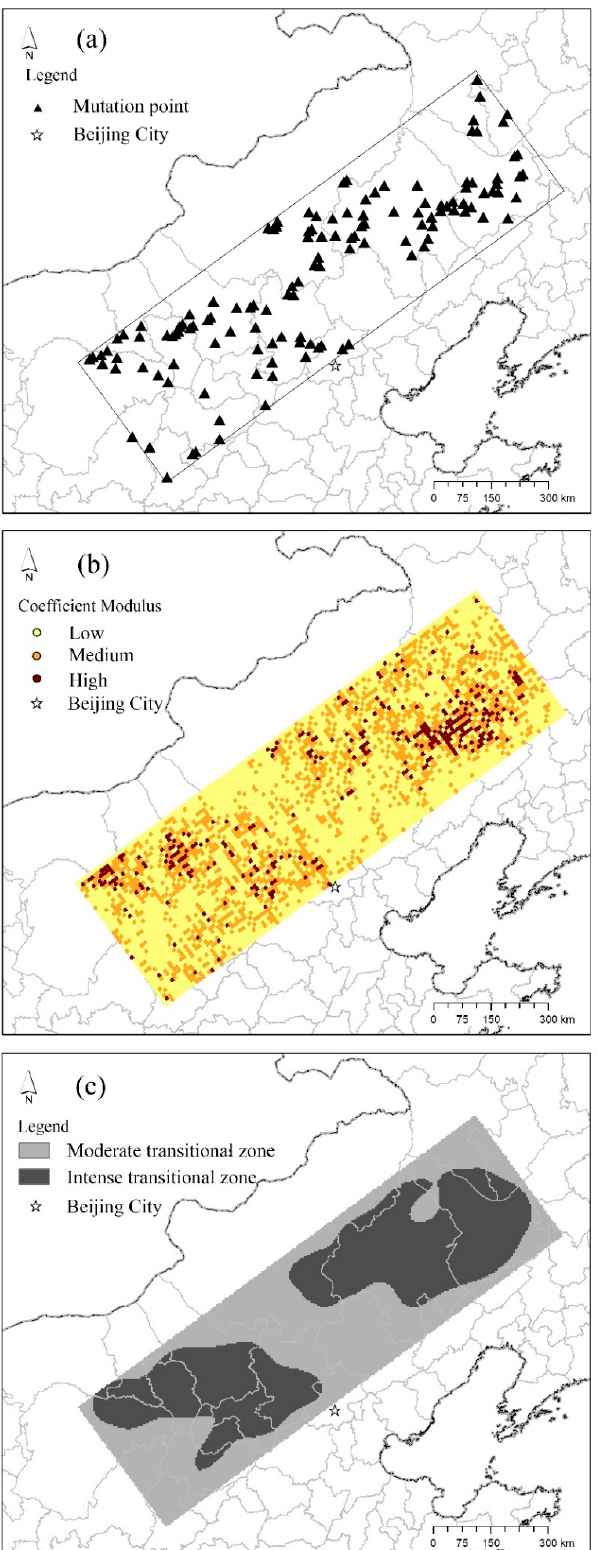
Figure 3. Spatial pattern of the wavelet coefficients modulus, using mean normalized difference vegetation index (NDVI) for the period 2006–2015. ( a ) Mutation points of each NDVI sequence; ( b ) classification of the wavelet coefficients module; ( c ) classification of the kernel density of the wavelet coefficients module.